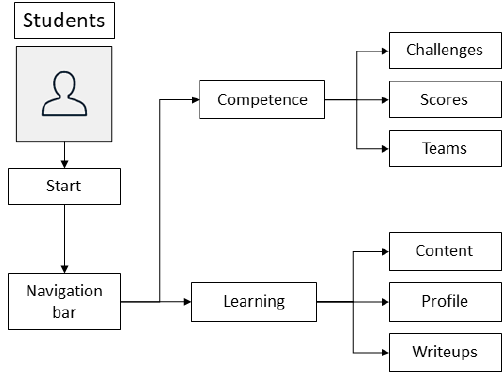
Figure 4. Student role block diagram.